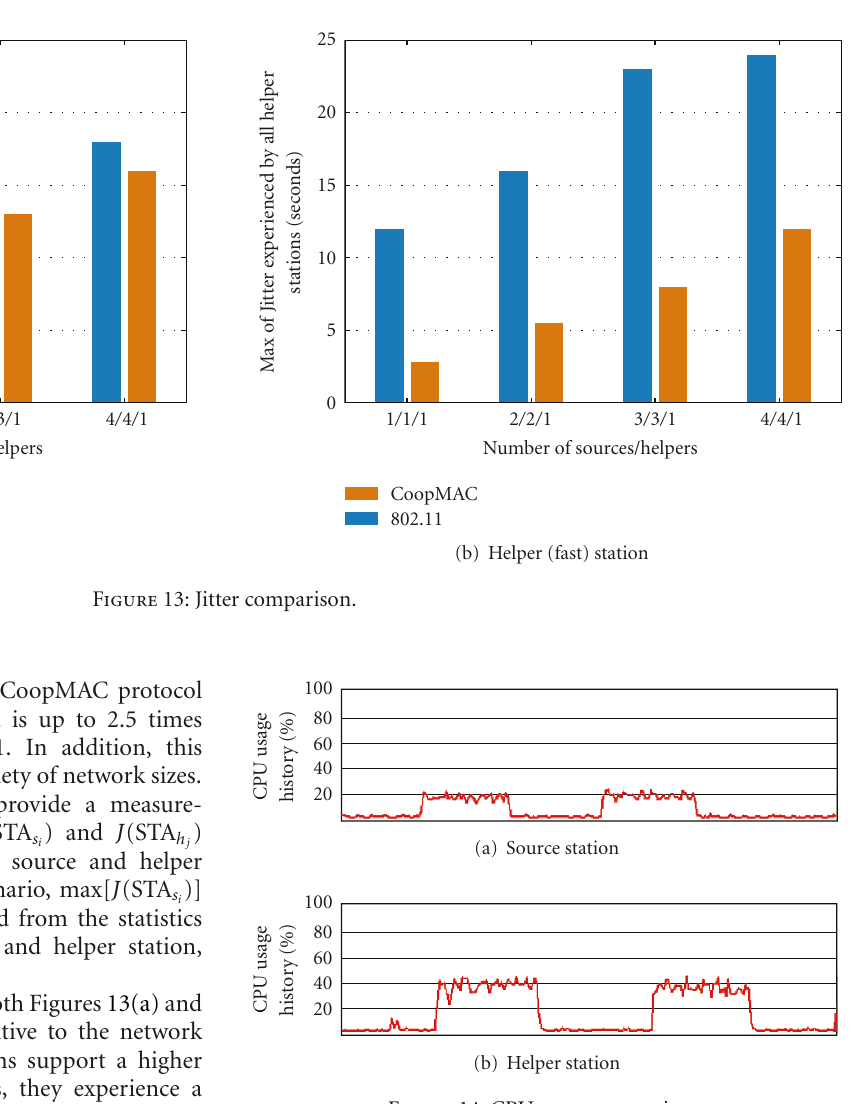
Figure 14: CPU usage